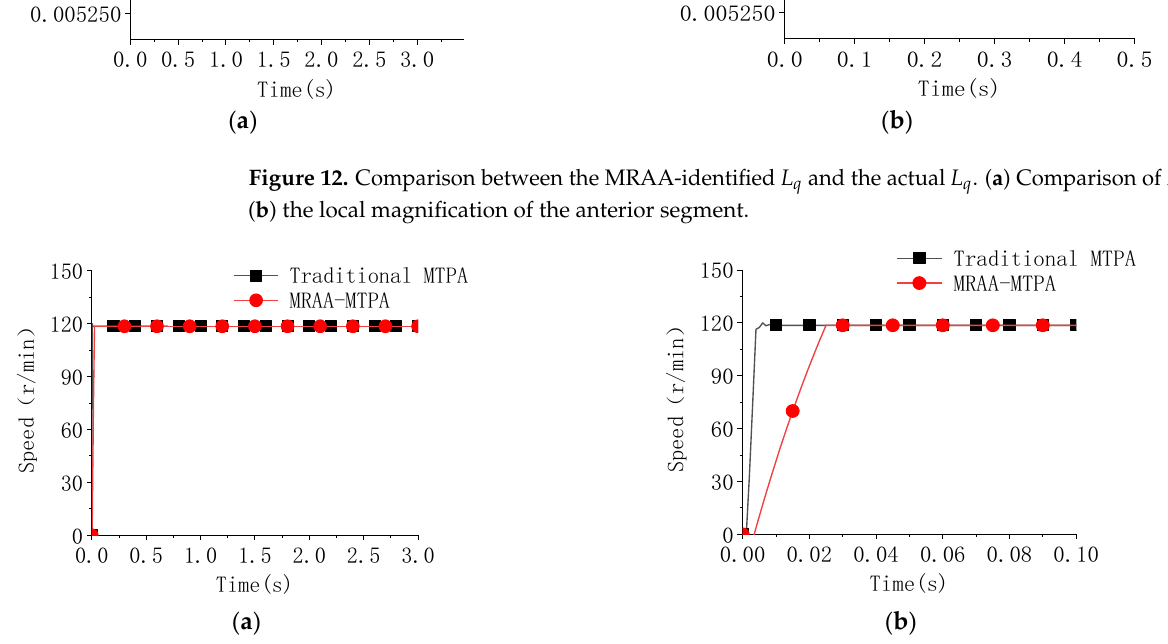
Figure 13. Speed comparison between MRAA-MTPA control and fixed-parameter MTPA control. ( a ) Comparison of speed and ( b ) the local magnification of the anterior segment.